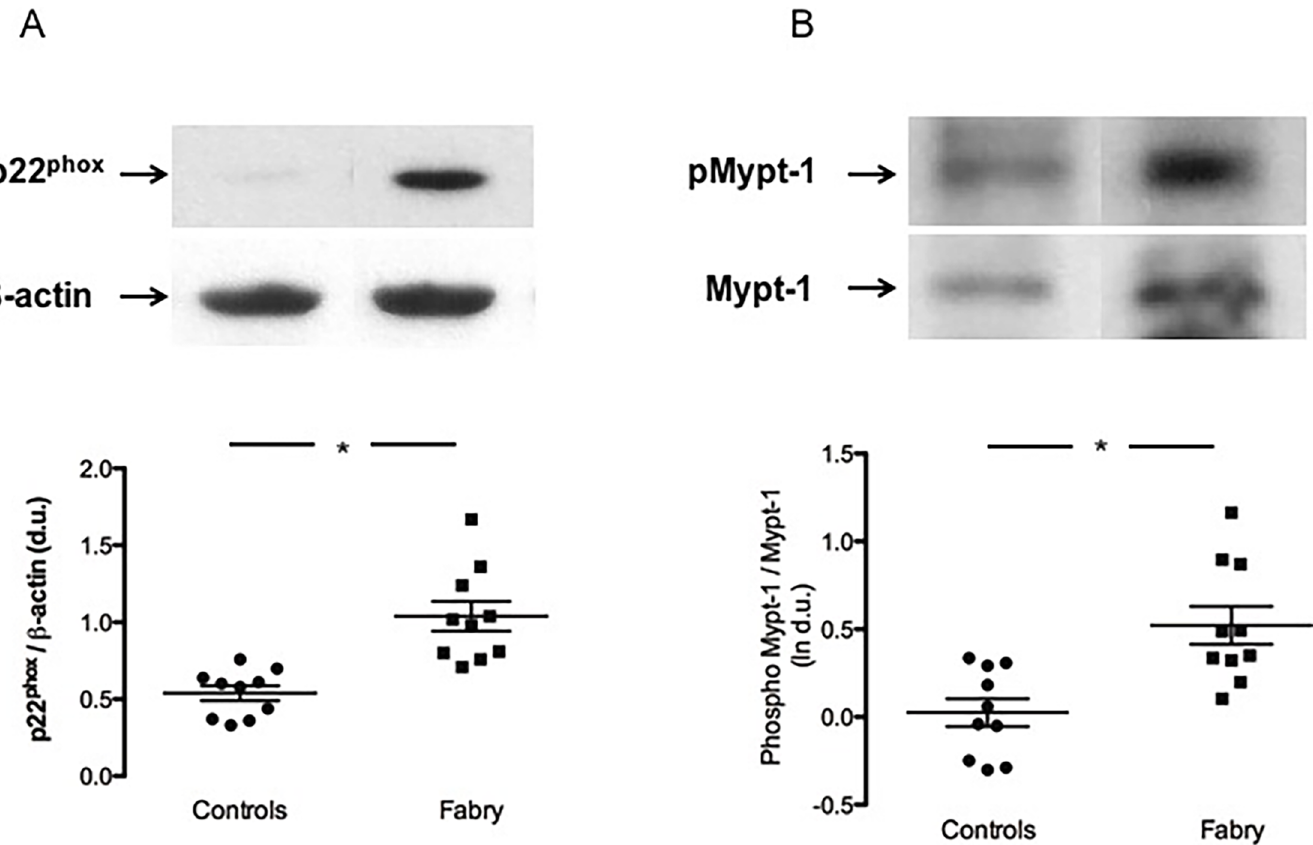
Fig 1. panel A: p22 phox protein expression. Representative Western blot of protein lysates harvested from healthy subjects (Controls) and patients (Fabry), (Top of the figure). Densitometric analysis of Western blot products showing the higher expression of p22 phox in Fabry patients, compared to healthy subjects. Data are shown ± SEM. (cid:3) : p < 0.01. panel B: MYPT-1 phosphorylation state. Representative Western blot of phosphorylated MYPT-1 and MYPT-1 (Top of the figure). The densitometric analysis, expressed as ln of d.u., shows higher phosphorylation of MYPT-1 in Fabry patients compared to healthy subjects. Data are shown ± SEM. (cid:3) : p < 0.01.